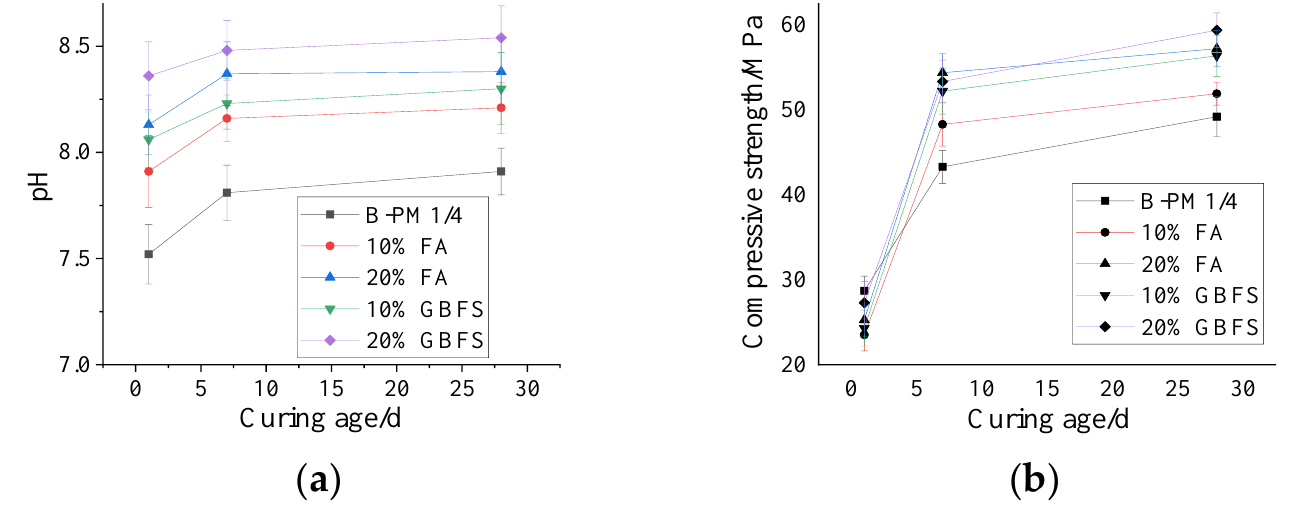
Figure 2. Effect of mineral admixtures on ( a ) alkalinity and ( b ) compressive strength of MPC.